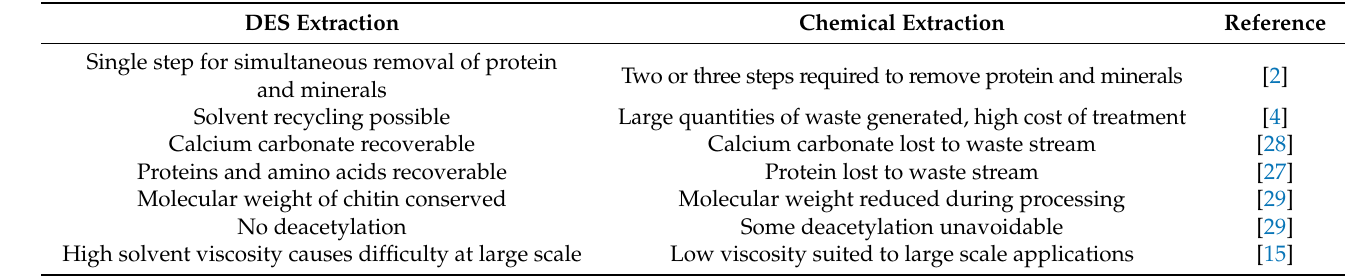
Table 4. Advantages and disadvantages of DES- and chemical-mediated extractions. DES Extraction Chemical